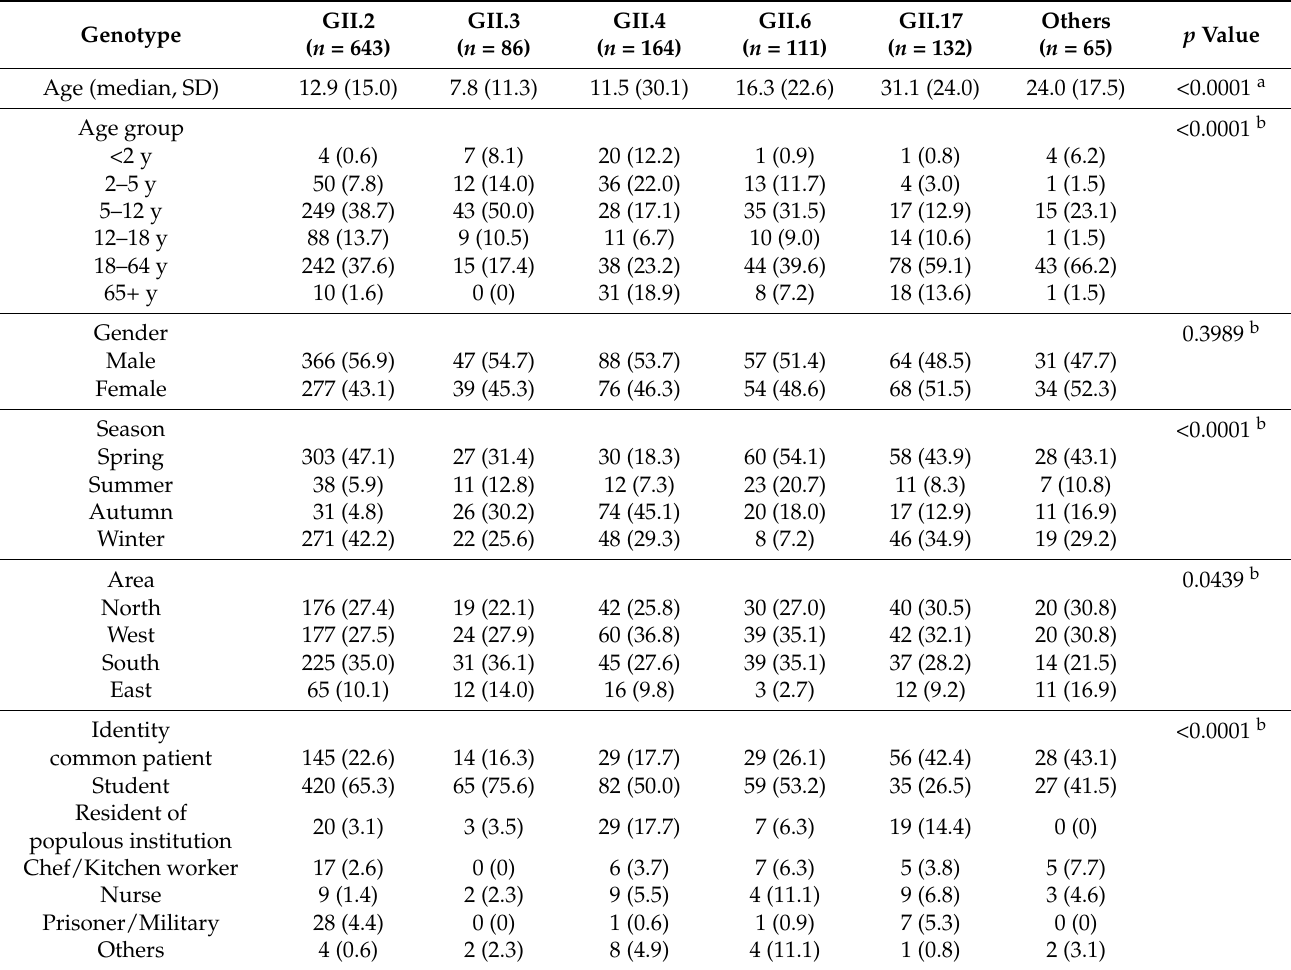
Table 1. Demographic data of patients infected with norovirus by GII genotype in Taiwan, 2015–2019. Genotype